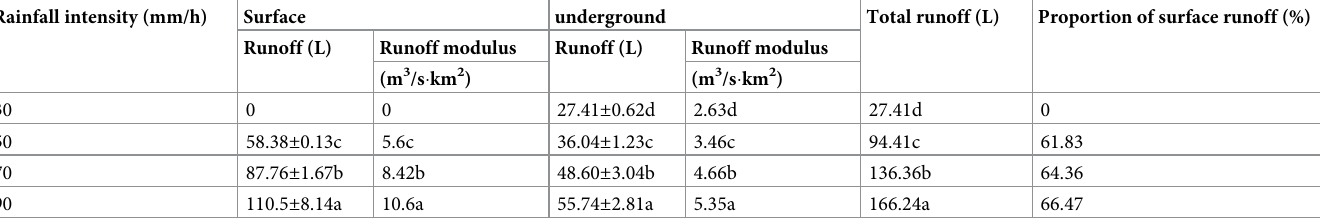
Table 2. Surface and underground runoff loss characteristics under different rainfall intensities. Rainfall intensity